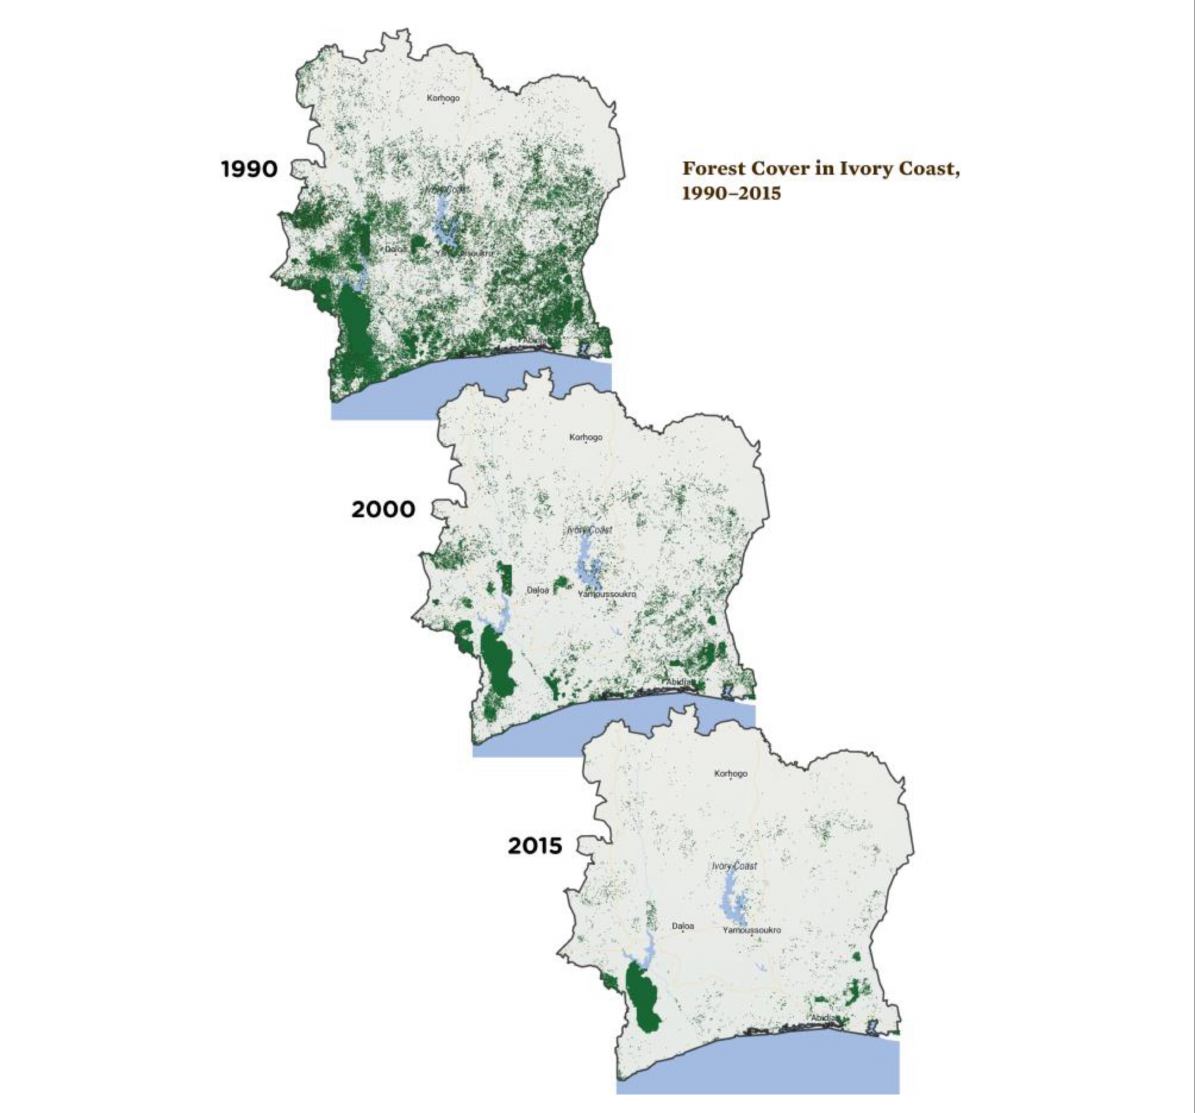
FIGURE3 Forest cover (depicted in green) in the Ivory Coast in 1990, 2000, and 2015 (figure adapted with permission from Higonnet et al., 2017). In 2015 the remaining forest in the Ivory Coast was primarily in protected areas, but much of the wildlife in these areas has been dramatically reduced by bushmeat hunting (N’Goran et al.,